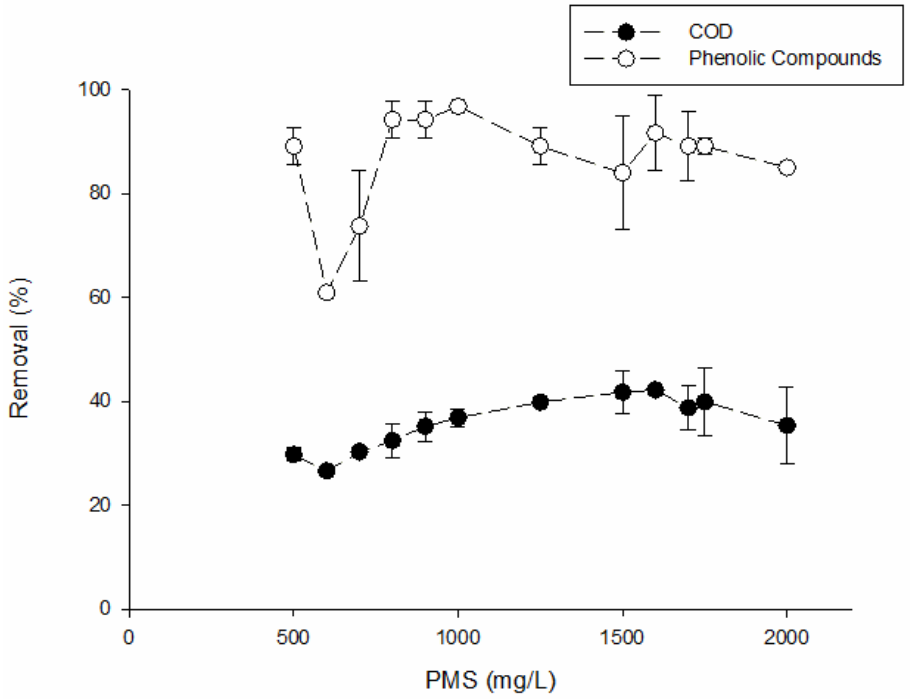
Figure 2. PMS load influence on COD and phenolic compounds removal ([Fe 2+ ] = 300 mg/L, pH = 5 after 30 min of reaction).